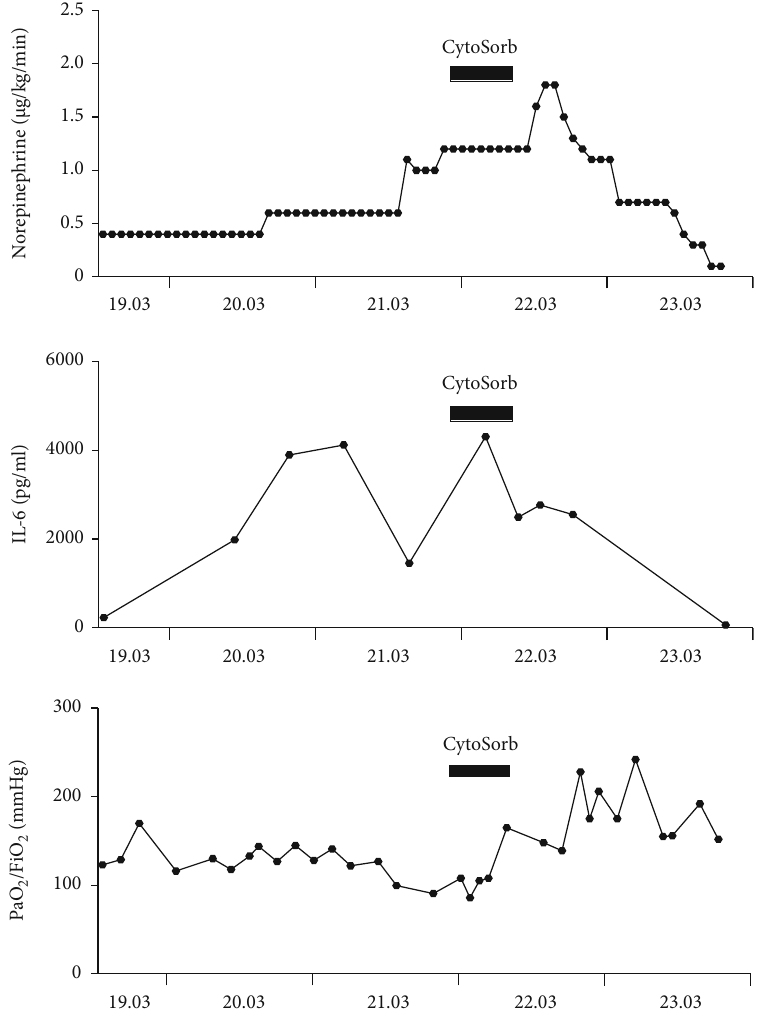
Figure 1: Course of norepinephrine, IL-6, and PaO